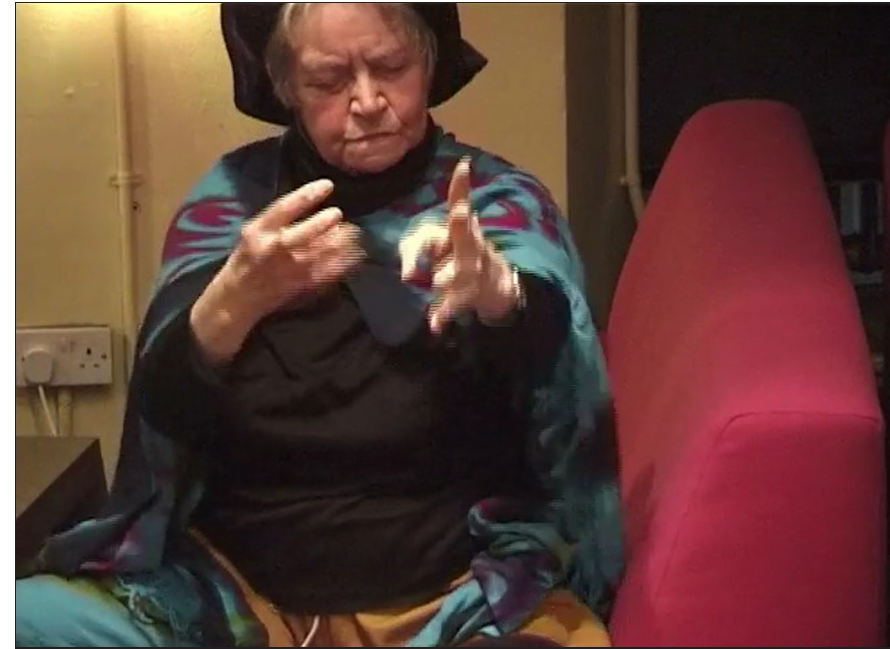
Figure 2.3: (49.11) Jennifer Pike with Birdyak at the RCA, London 2002. Courtesy of William